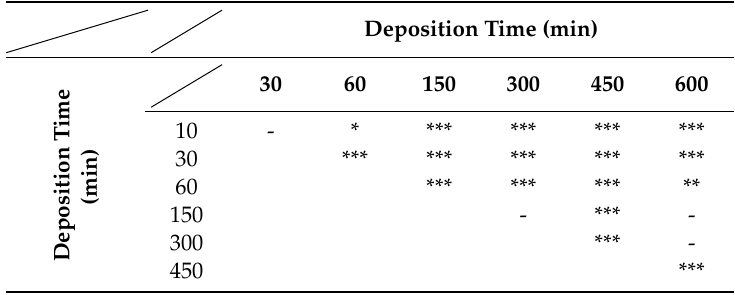
Table 4. Statistical analysis of the number of pores across a variety of surfaces. p > 0.05: p < 0.05: